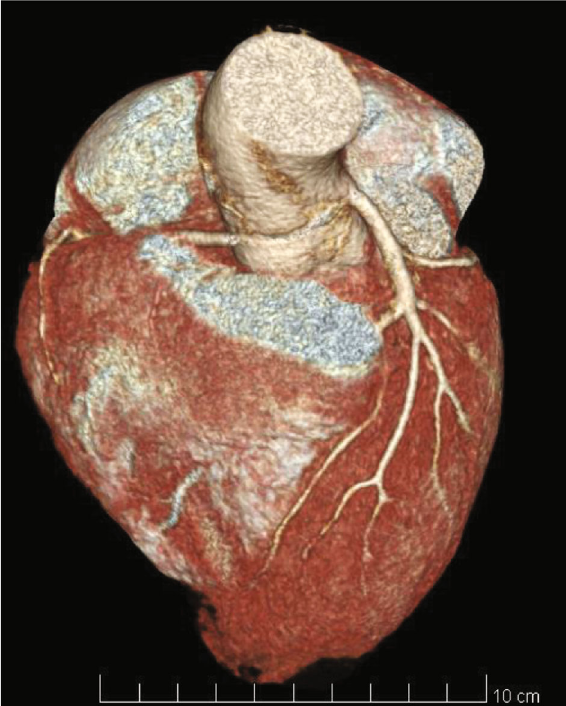
Figure 1: Coronary computed tomography showing the intramural path of the right coronary artery with origin close to the left coronary artery.